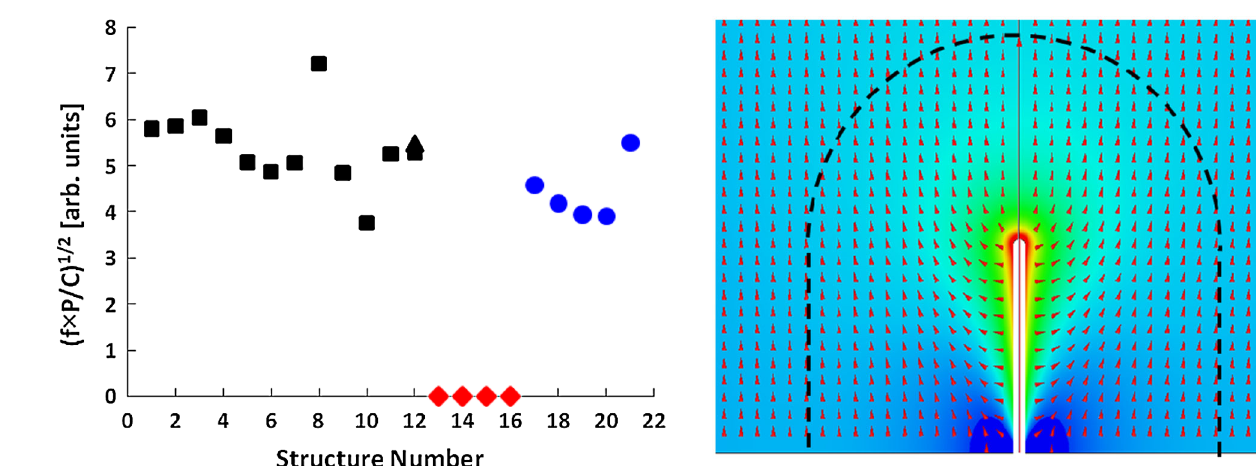
value.FIG. 5. (Color) Square root of f (cid:4) P=C is plotted for the data presented in Fig.